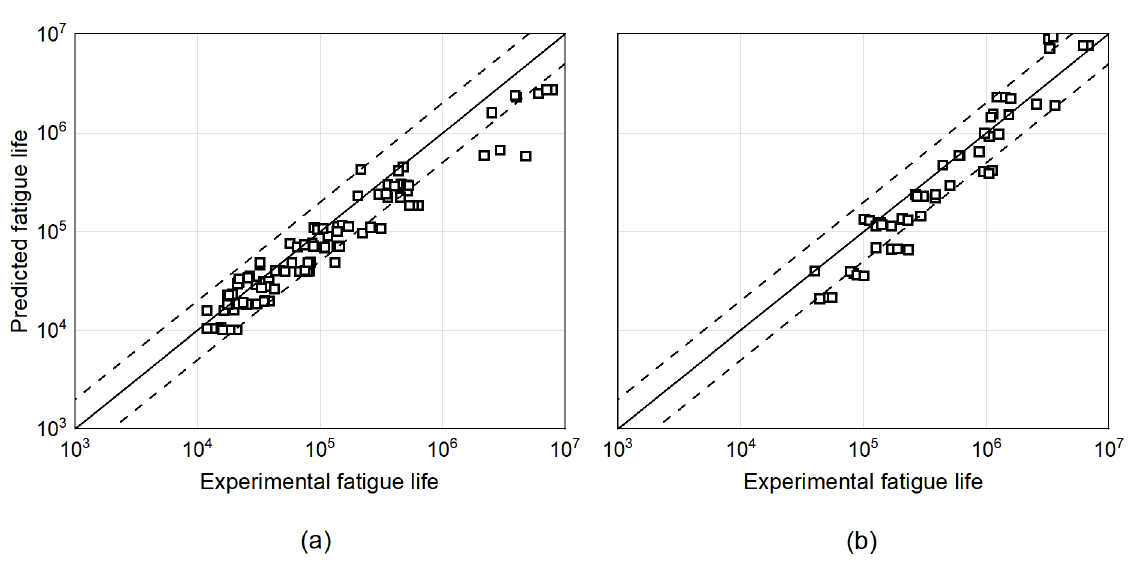
Figure 16. Results of FCG-based model fatigue life correlation to the experimental fatigue life obtained for Ti6Al4V ( a ) and Inconel 718 ( b